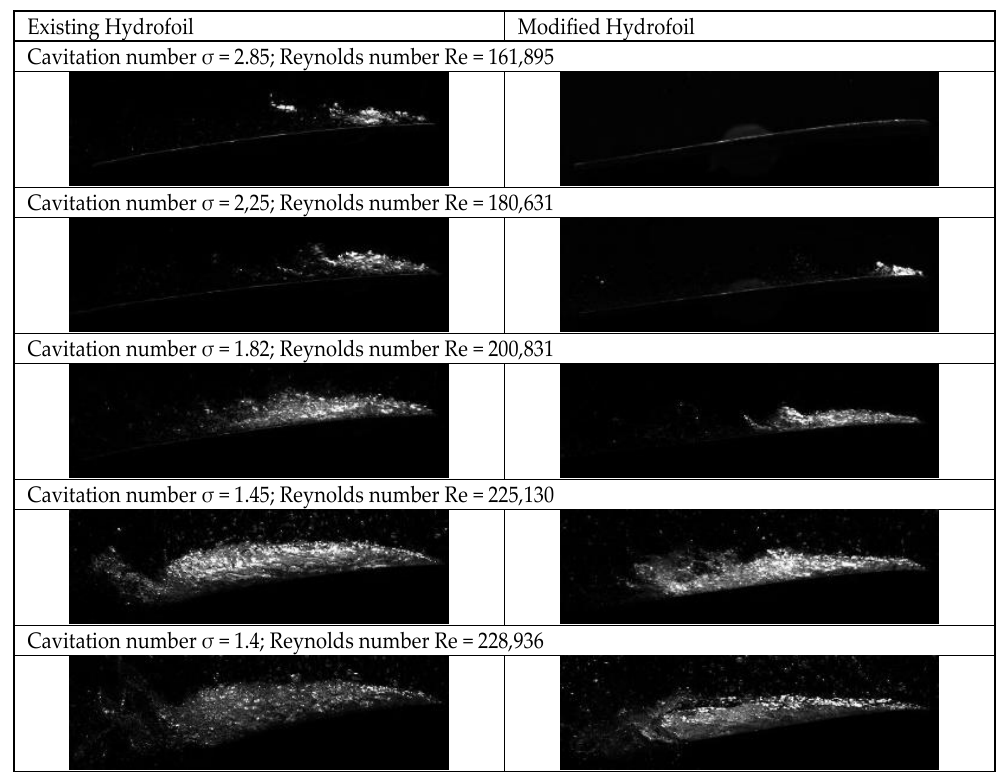
Figure 12. Visualization results of cavitation structures at p abs = 0.30 bar.